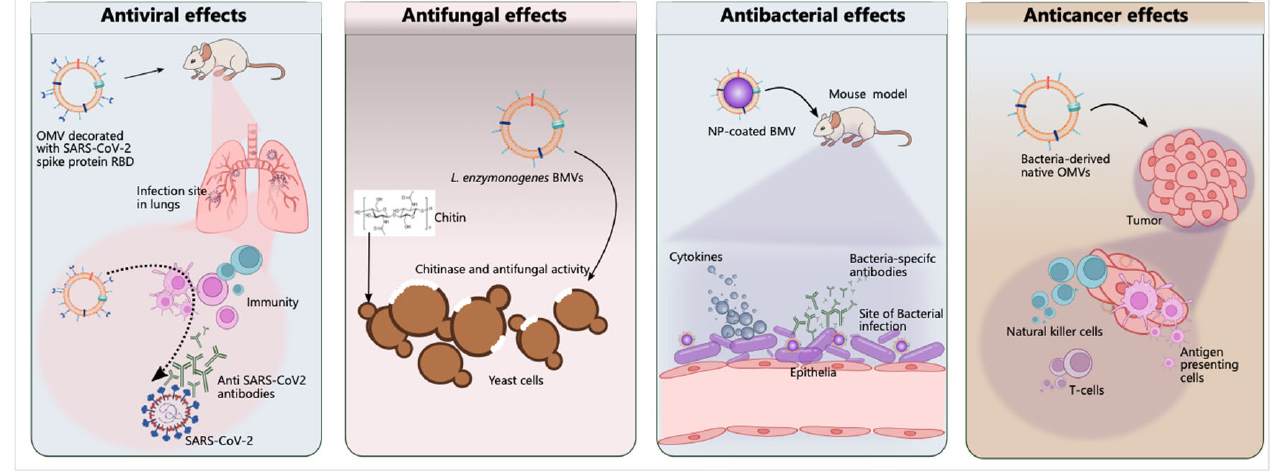
Figure 5. Potential uses of BMVs in antimicrobial and anticancer therapy.